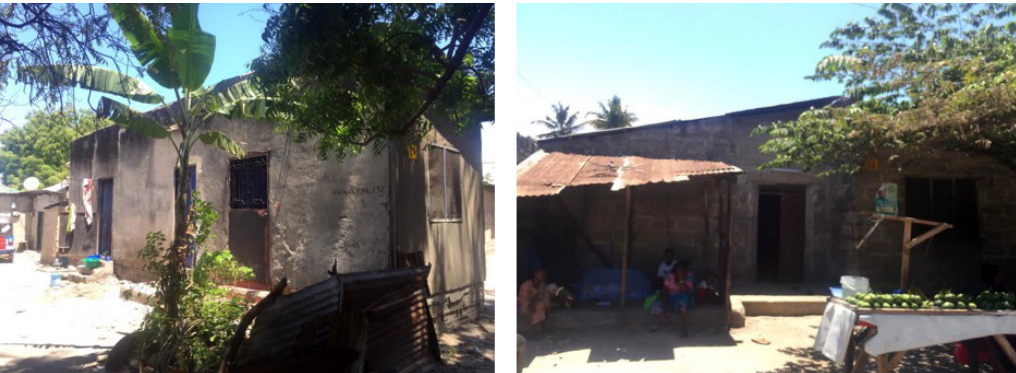
Figure 3. The simple layout and flexible structure of a Swahili house: The courtyard (left) and a front veranda (right),